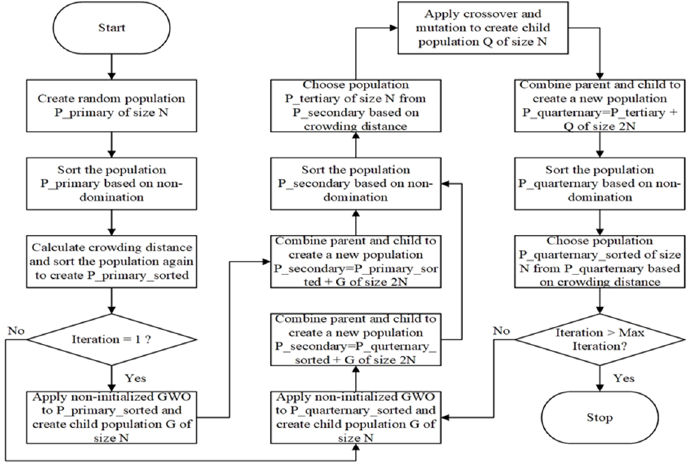
Figure 4. Implementation steps of hybrid (NSGA-GWO) multi-objective optimization algorithm for optimal sizing of a hybrid renewable energy system. optimal sizing of a hybrid renewable energy